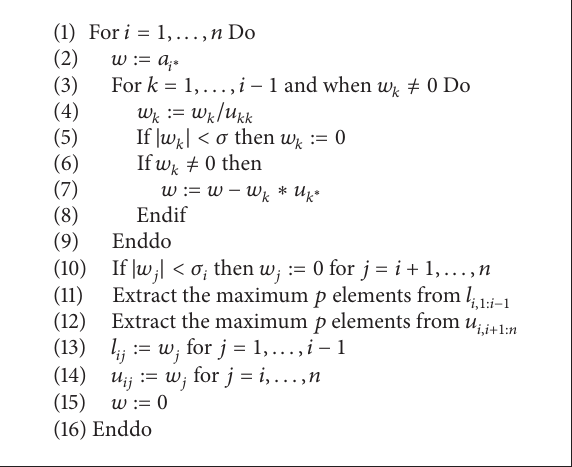
Algorithm 1: Algorithm ILUT( 𝑝,𝜎 ).